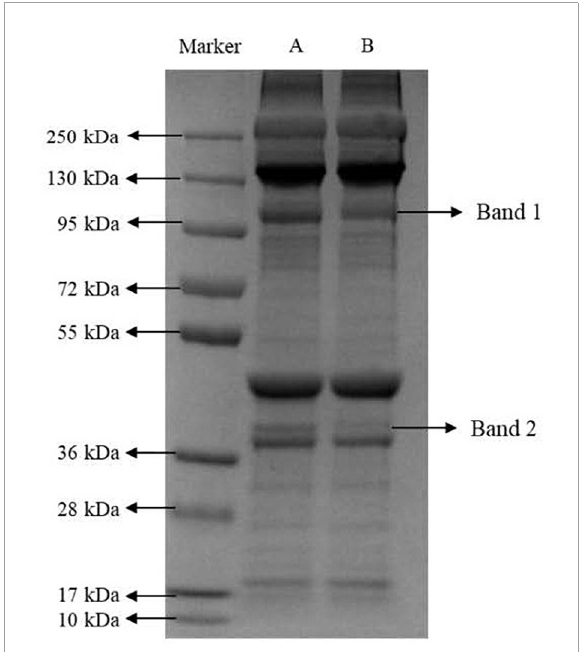
FIGURE3 Representative image of SDS-PAGE gels of myofibrillar proteins in chicken breast by marinating treatment. The chicken breasts treated with immersion and vacuum tumbling marinating were denoted as A and B,